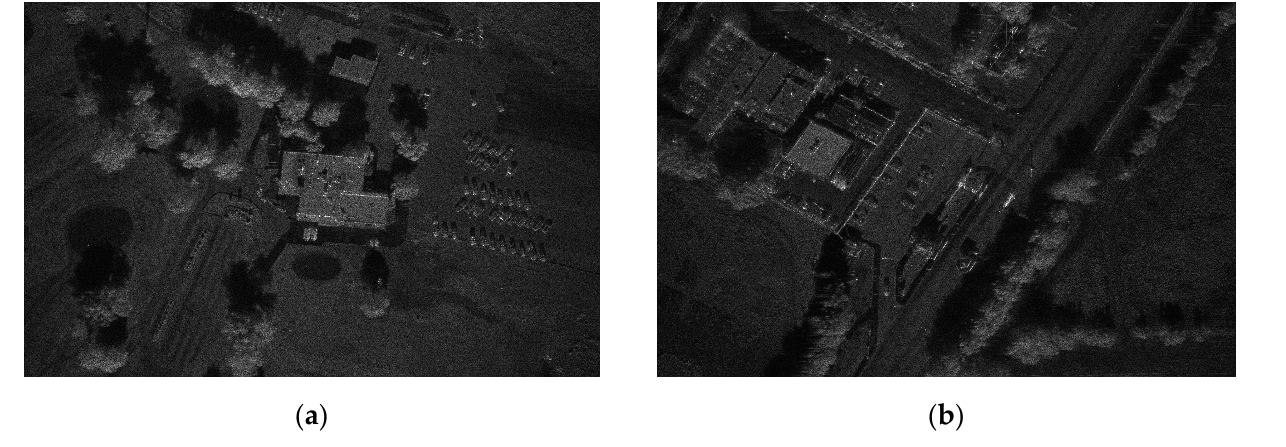
Figure 5. Two images of miniSAR dataset: ( a ) image I ( b ) image II. The original SAR image had a large size, which was not suitable for being the input in the network. Therefore, when training, the original training SAR images were cropped into many SAR sub-images with a fixed size of 300 × 300, according to the input size of the network. These sub-images consist of sub-images that contain the targets and sub-images that do not contain the targets and only contain background clutter. Then these sub-images were used as training images for the network. When used in the test, the original test SAR images were also cropped into many test SAR sub-images with the size of 300 × 300 using a sliding window. There was overlap when moving one sliding window to the next, which was 100. Then, all of the test SAR sub-images were input to the target detection network, and the prediction results of all sub-images were restored to the original SAR image. Finally, the NMS deduplication algorithm was employed to obtain the final detection results. In our experiment, for each image-level labeled training sample, we only marked whether it contains the targets, while for each target-level labeled training sample, it must contain the targets, and the positions of the targets must be marked. The image-level labeled training samples are composed of all training sub-images, and they were only marked at image-level. The target-level labeled training samples are only composed of the training sub-images that contain the targets, and they were marked at target-level. The proposed method uses only 30% target-level labeled training samples (except for the Section 4.4.2) and all image-level labeled training samples, in which the 30% target-level labeled training samples were randomly selected from all the target-level labeled training samples ten times, and their results were averaged over the ten different choices as the final test result. Please note that the 30% here is relative to the target-level labeled training samples, but not relative to all the training samples. For Section 4.4.2, which analyzes the variations of detection performance with the percentage of target-level labeled training samples, the percentage of target-level labeled training samples increased from 10% to 100%. The experiments are implemented with the Caffe [25] deep learning framework, using a personal computer with Intel Xeon E5-2630 v4 CPU of 2.2 GHz, NVIDIA GeForce GTX 1080 Ti GPU, and 128 GB of memory on Ubuntu 18.04 Linux